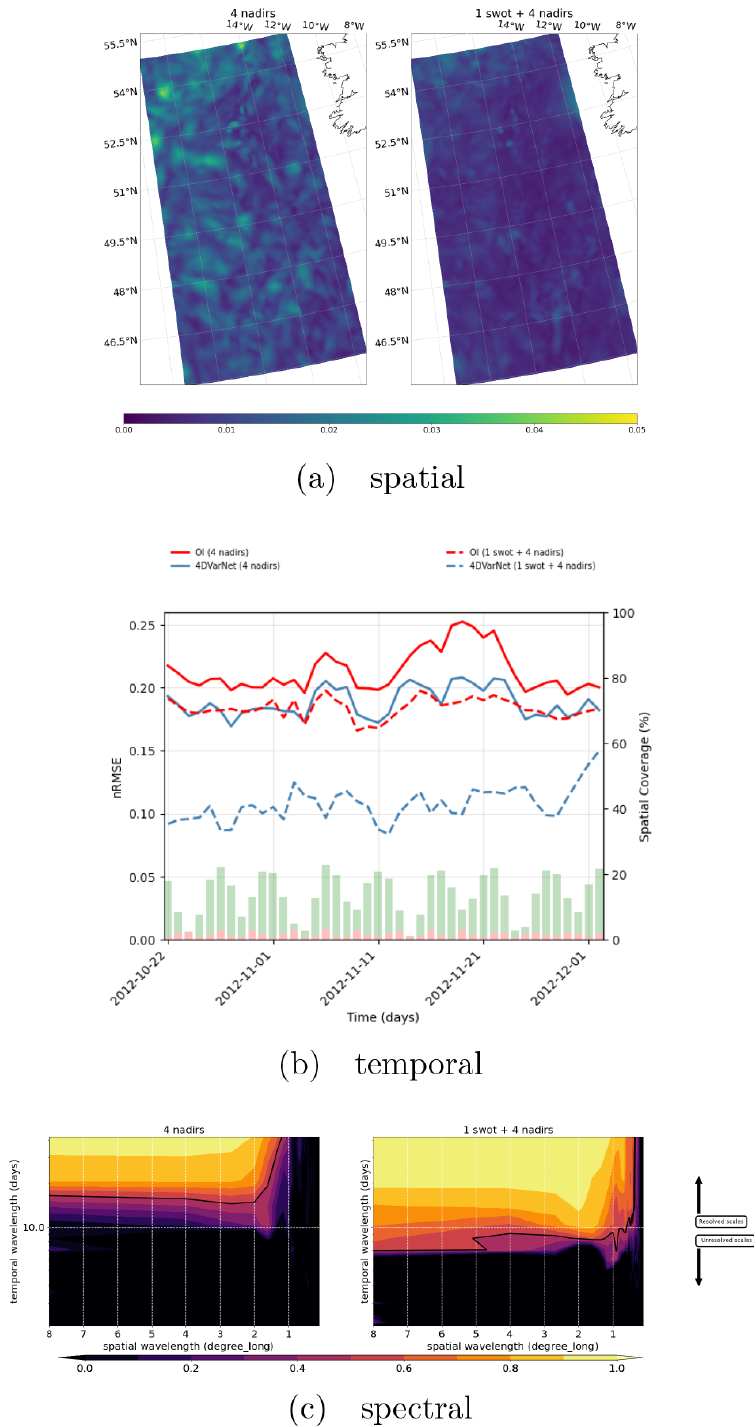
Figure 9. (a) Spatial performance, where the RMSE time series are computed for each spatial position of the GULFSTREAM domain (four nadirs on the left and one SWOT plus four nadirs on the right). (b) Temporal performance, where the RMSE daily GULFSTREAM maps are computed along the BOOST-SWOT DC evaluation period (four nadirs on the left and one SWOT plus four nadirs on the right), and the daily spatial coverage of the two configurations are given as complementary red and green bar plots scaled on the right-hand side. (c) Spectral performance, where the PSD-based score evaluates the spatiotemporal scales resolved in GULFSTREAM mapping (yellow area; four nadirs at the top and one SWOT plus four nadirs at the